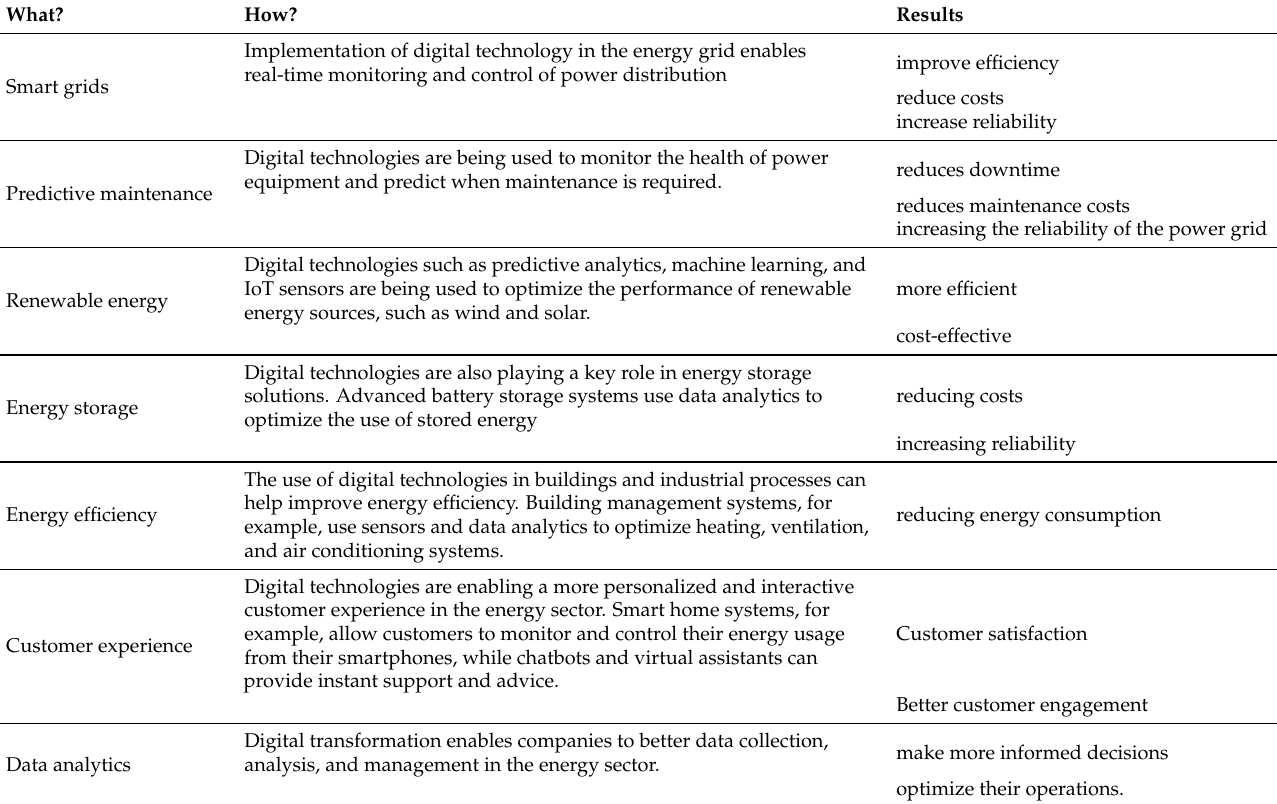
Table 6. Ways digital transformation has impacted the power